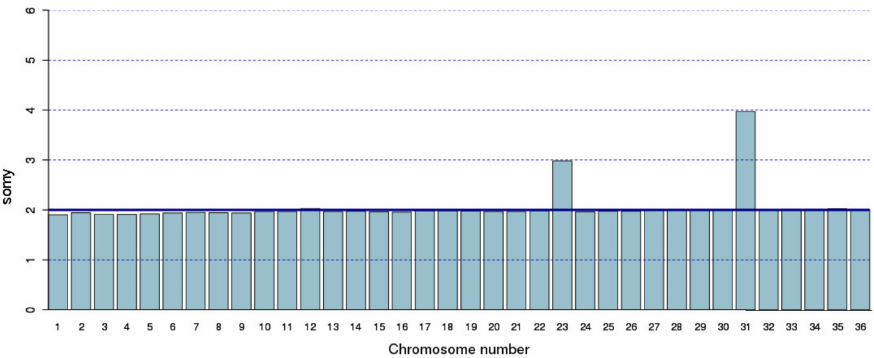
Figure 7. Somy analysis of the 36 chromosomes composing the L. major (Friedlin strain) genome. The somy values were calculated from the coverage of Illumina reads mapped to the LMJFC assembly, as detailed in Methods section. Graphs were generated with R, using the barplot function (https://cran.r-project.org accessed on 27 May